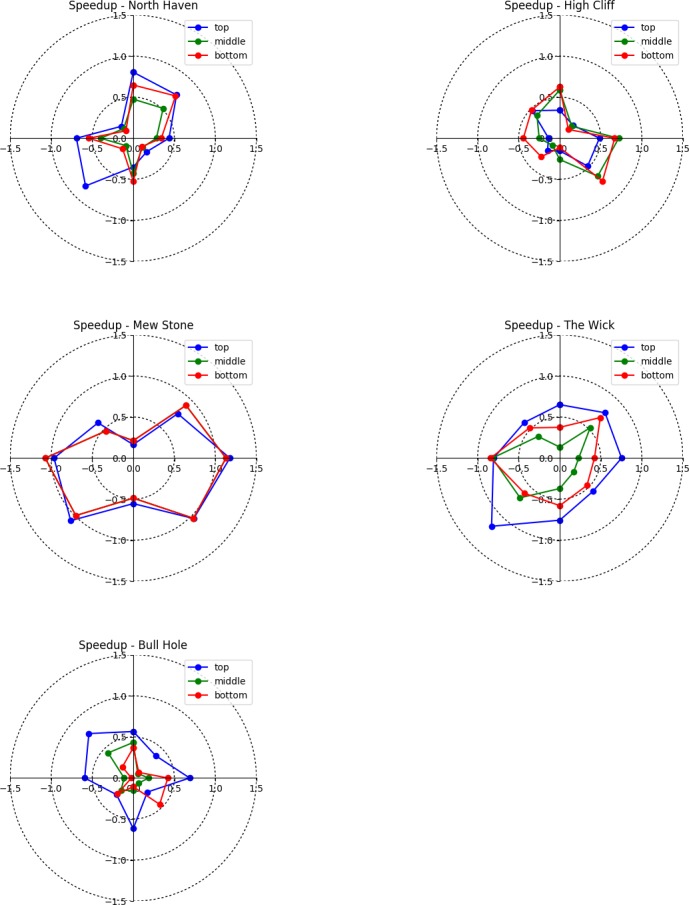
The mean wind speed at each colony is shown relative to the value at over the sea, where values < 1 indicate a reduction in wind speed close to the cliffs.Within each colony, relative wind speeds are shown at different heights (observer locations are marked as top, the vertical mid-point of the cliff is given as middle, and bottom gives conditions at the base of the cliff). At most cliff sites the speed is less than upwind, a pattern that is particularly evident at the base of the cliffs. The only exception to this is at the Mew Stone where flow is channelled between the rock and the main island in westerly/easterly wind directions, leading to higher speeds.